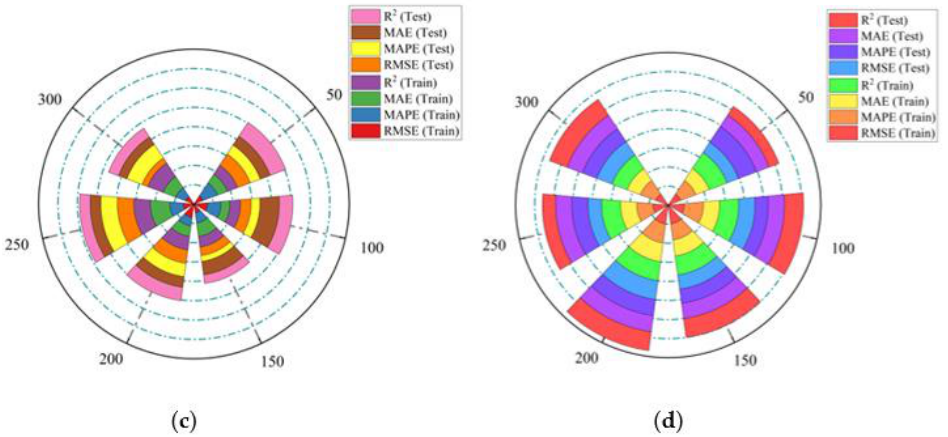
Figure 10. Comparison of evaluation indexes for MC prediction algorithms: ( a ) PSO-XGBoost; ( b ) ACO-XGBoost; ( c ) SOA-XGBoost; ( d ) IGWO-XGBoost.